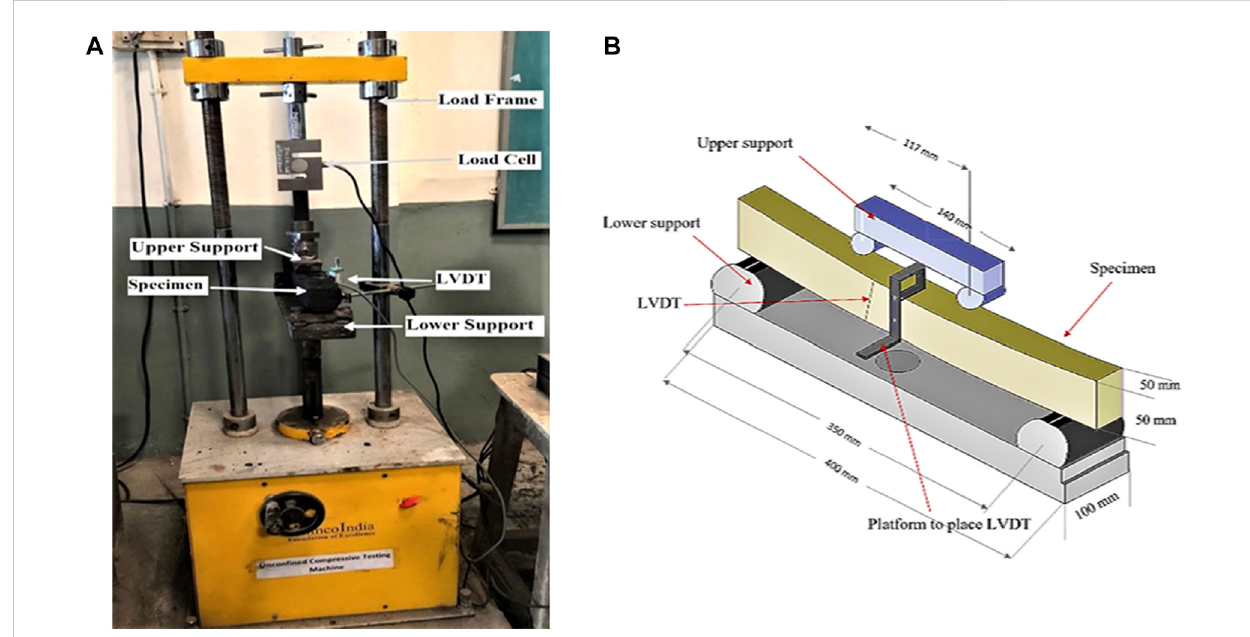
FIGURE 7 Dimensions of the fabricated tool for fl exural test. (A) Real Dimensions; (B) Sketch